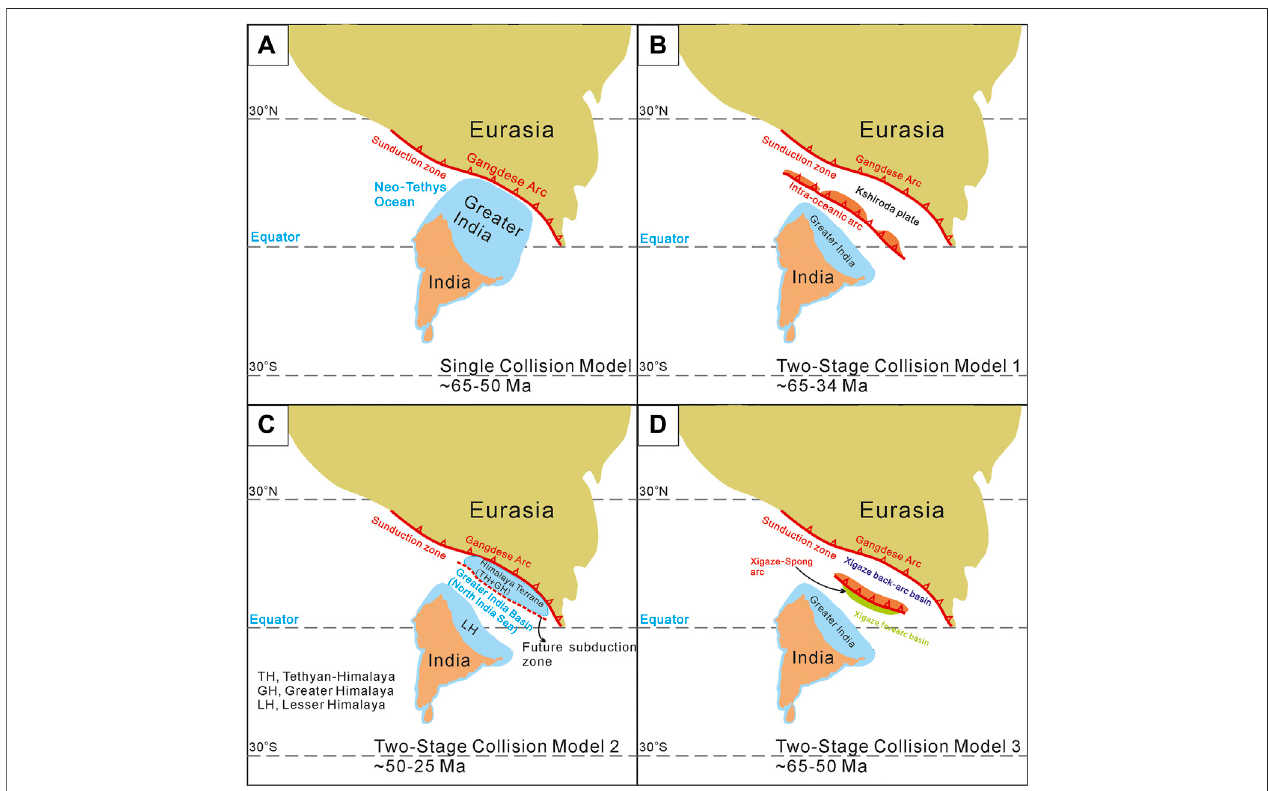
FIGURE 1 | Four competing tectonic models for interpreting the initial India – Asia collision in early Cenozoic time. (A) Single-stage collision model derived from Gansser, (1966), Patzelt et al. (1996) and Parsons et al. (2020); (B) Two-stage collision model 1, which was proposed by Patriat and Achache (1984); (C) Two-stage collision model 2,which is fi rstly quanti fi ed bypaleomagnetic analysis (van Hinsbergen et al., 2012, 2019);and (D) Two-stage collision model 3, which was proposed by Kapp and DeCelles (2019). Abbreviations are as follows: TH, Tethyan Himalaya; GH, Greater Himalaya; LH, Lesser Himalaya.